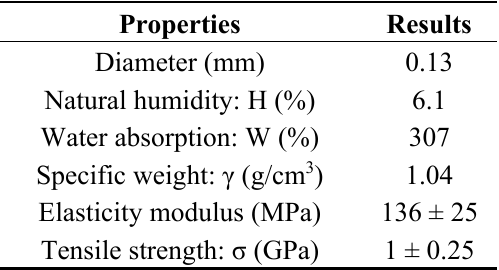
Table 3. Physical and mechanical properties of Kenaf